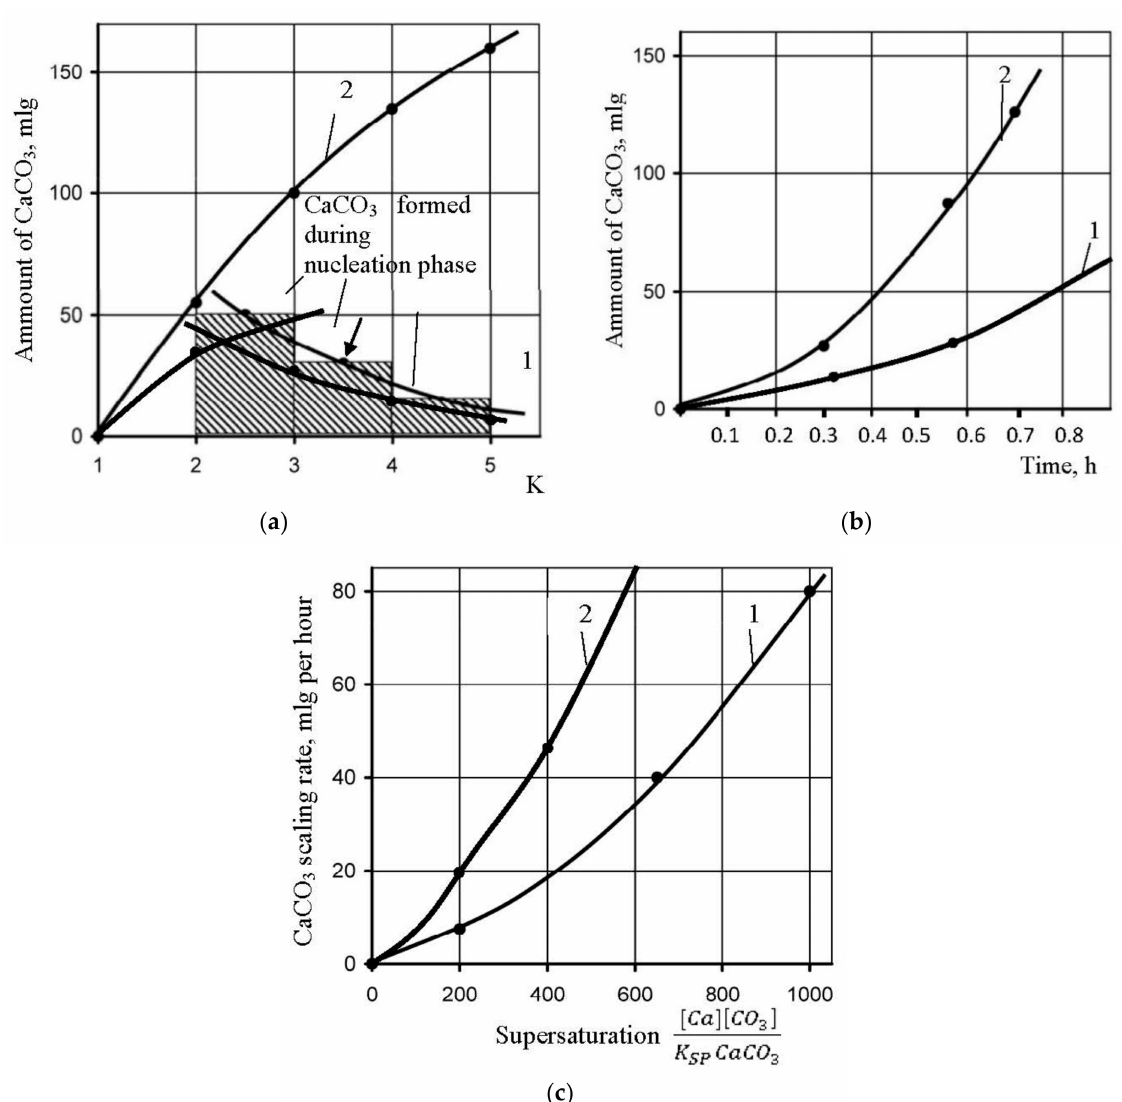
Figure 14. Evaluation of crystal growth rates: ( a ) dependencies of amount of grown calcium carbonate scale on K and amount of formed calcium carbonate during nucleation; ( b ) dependencies of grown calcium carbonate on time; ( c ) dependencies of grown calcium carbonate on supersaturation